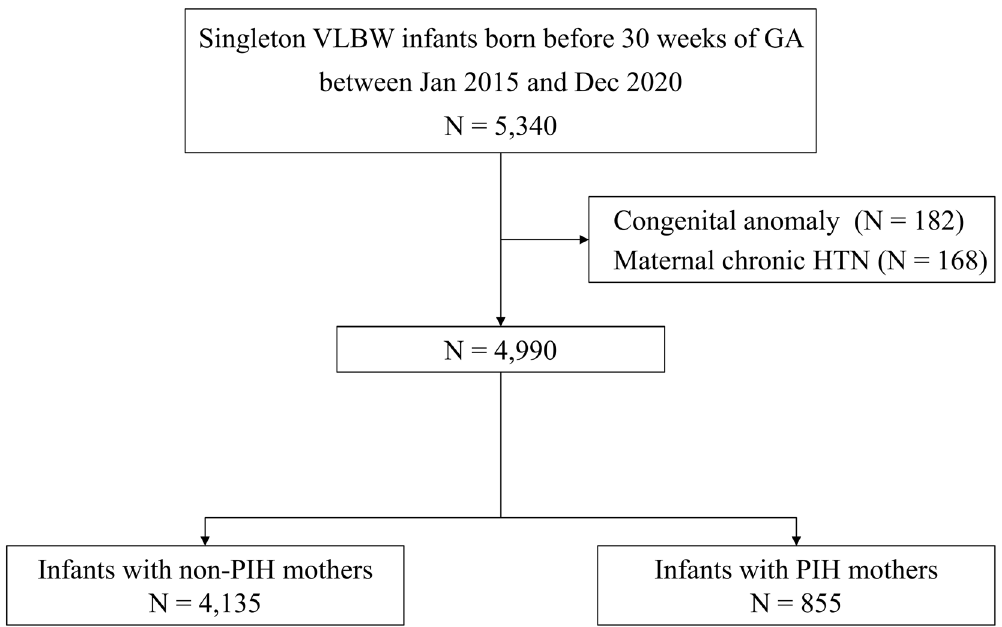
Figure 1. Flow diagram of the study population. VLBW Very low birth weight; GA Gestational age; HTN Hypertension; PIH Pregnancy-induced